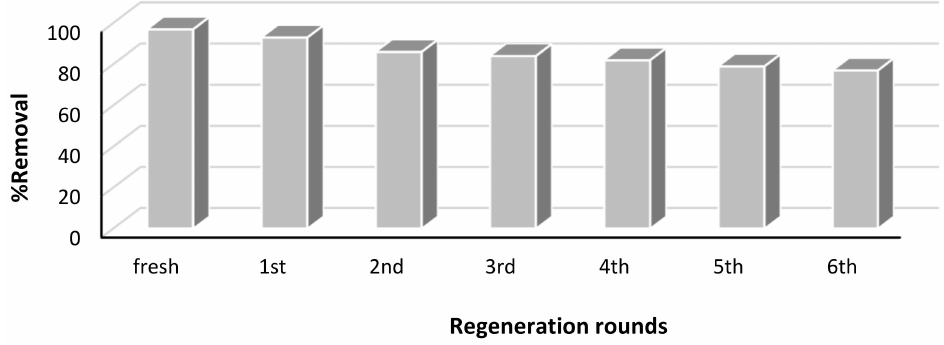
Figure 9. Regeneration of adsorbents Pd–Ni/AC on dye treatment.